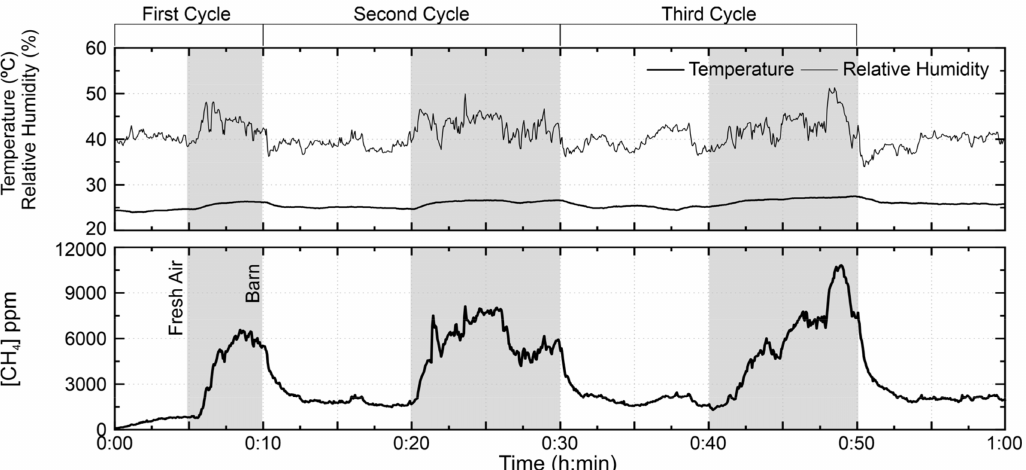
Figure 11. TGS2600 test on 21 April 2017 in the small ruminant barn of the Higher School of Agriculture of the Polytechnic Institute of Bragança. The test performed in three cycles, each integrating measurements outdoors and inside the barn with (quiet) animals. The shaded area corresponds to the sensor inside the barn, while the white area corresponds to the outdoor atmosphere (fresh